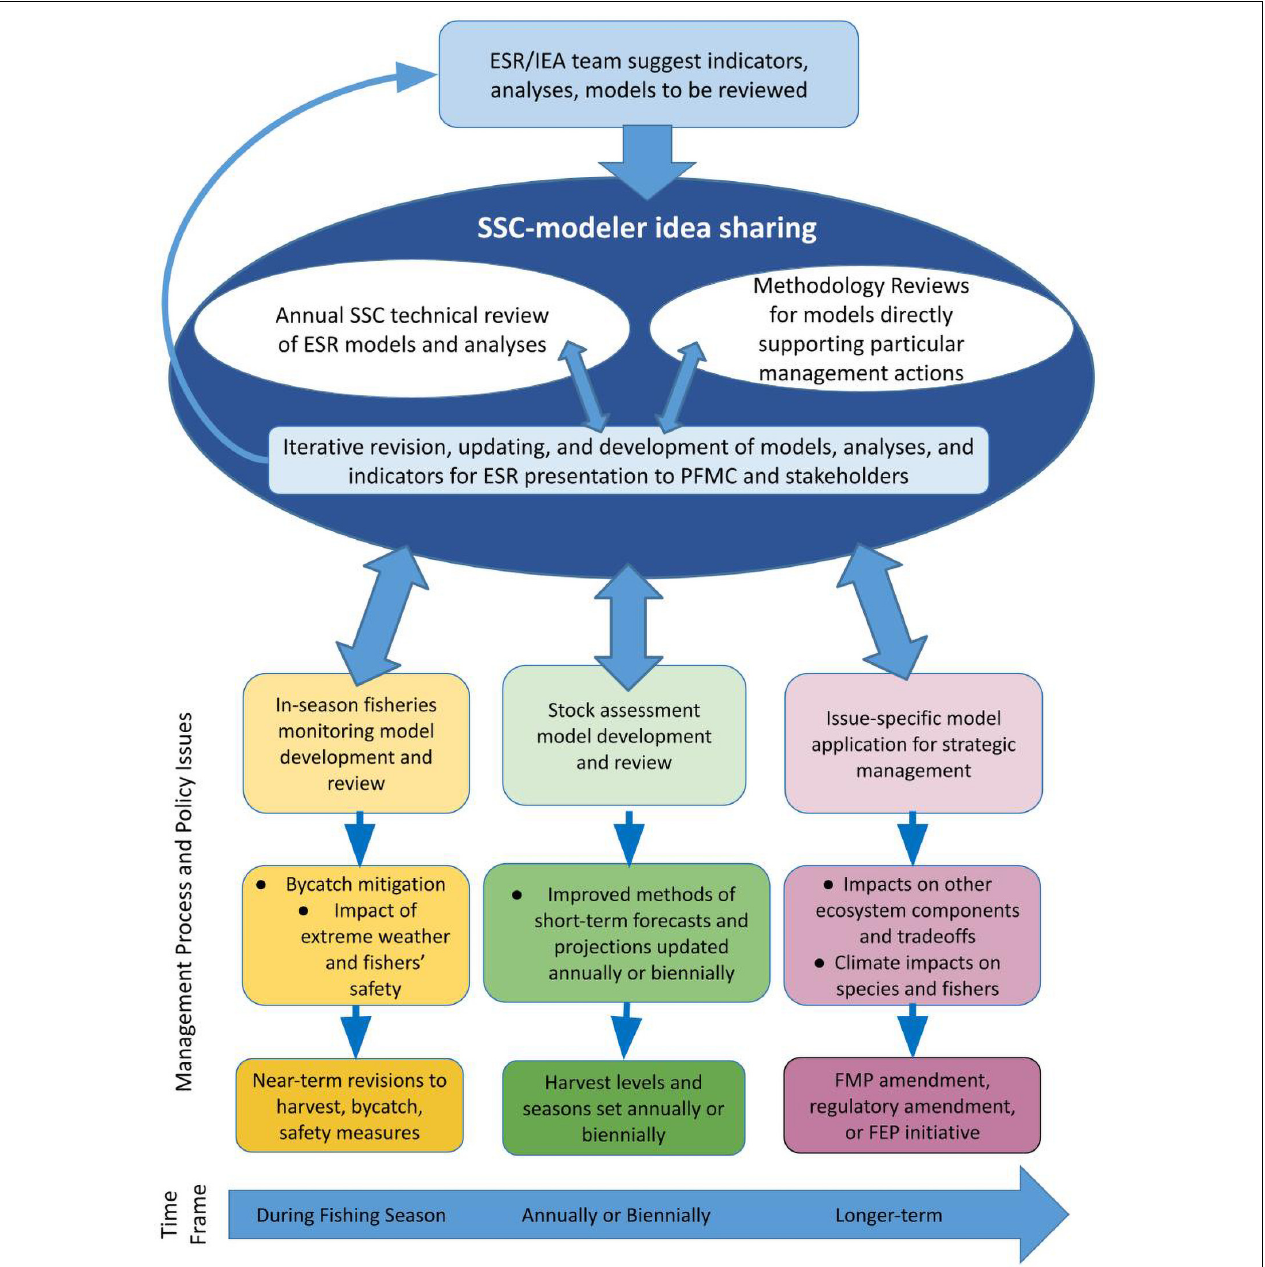
FIGURE 3 | Overview of the PFMC forum for routine discussion of ecosystem models and analyses and the management process and policy issues informed by those models and